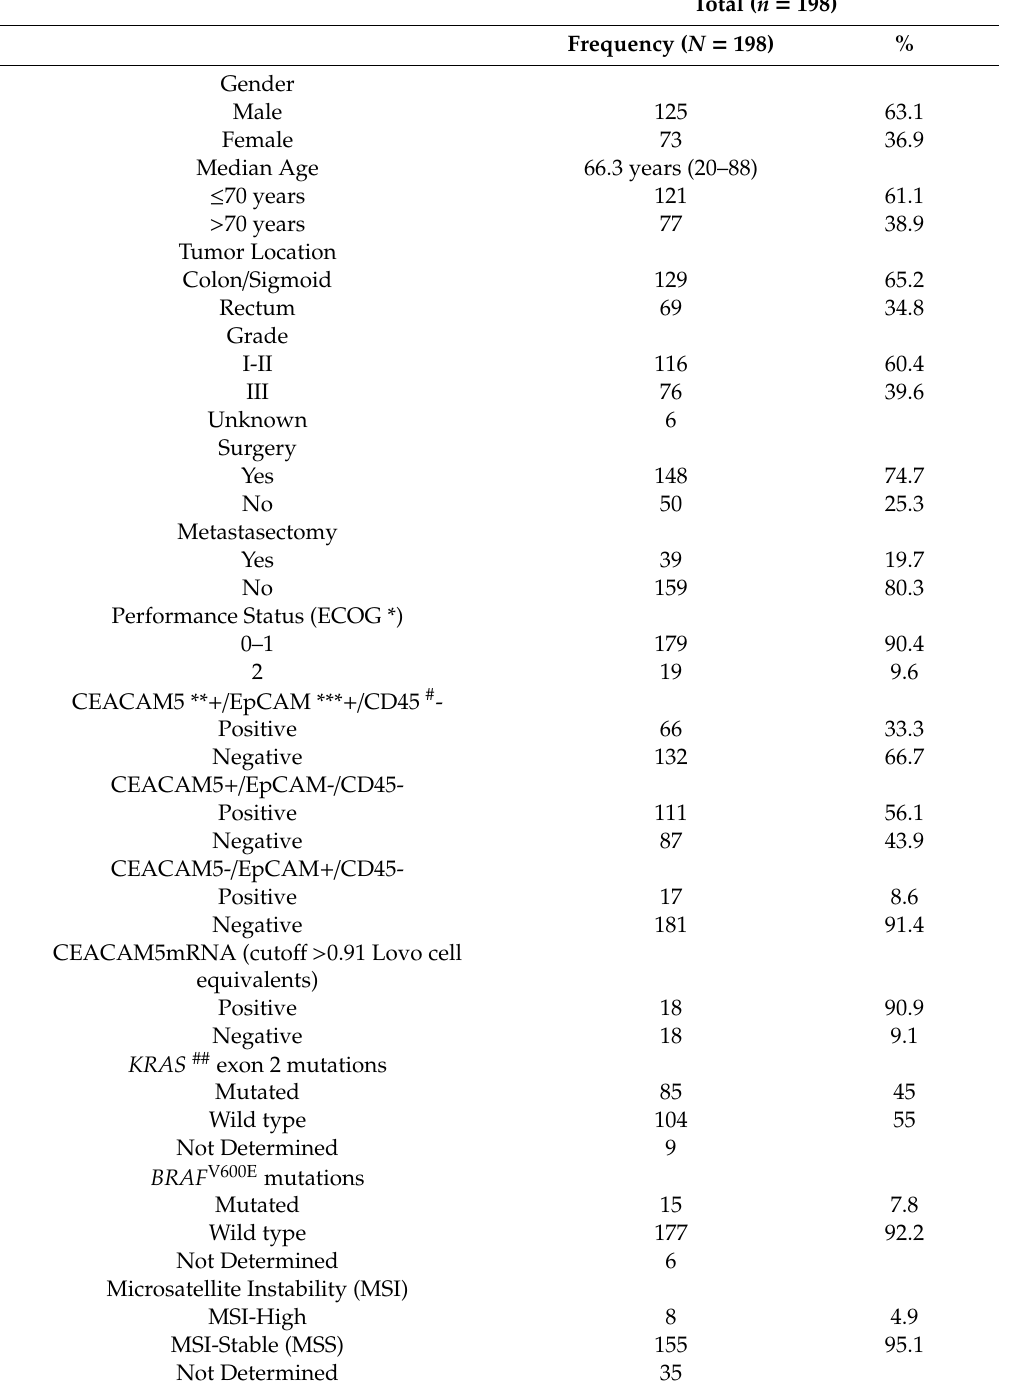
Table 1. Patients’ demographics and